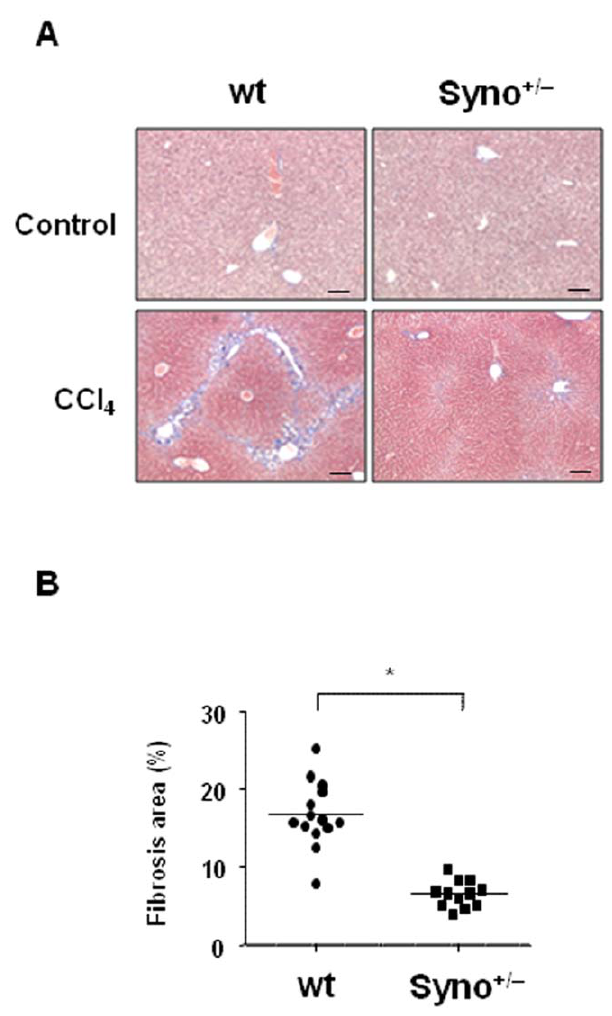
Figure 2. Decreased liver fibrogenesis in Syno + / 2 mice. (A) Liver fibrosis in wt and Syno + / 2 mice. Wild-type mice (wt: n=14) and Syno + / 2 mice (Syno + / 2 ; n=12) were injected with CCl 4 twice a week for 3 weeks. Then, liver fibrosis was evaluated by Masson’s trichrome staining. Wild- type mice (wt: n=2) and Syno + / 2 mice (Syno + / 2 ; n=2) that were treated with vehicle were used as negative controls (upper panels). Scale bar =200 m m. (B) Scatter diagram analysis of fibrosis areas in liver sections semiquantified using NIH Image software. Data are represent- ed as mean 6 SEM (wt: n=14, Syno + / 2 : n=12 of the CCl 4 -induced chronic hepatic injury model). Unpaired Student’s t -test was used for statistical analysis. * P , 0.001.